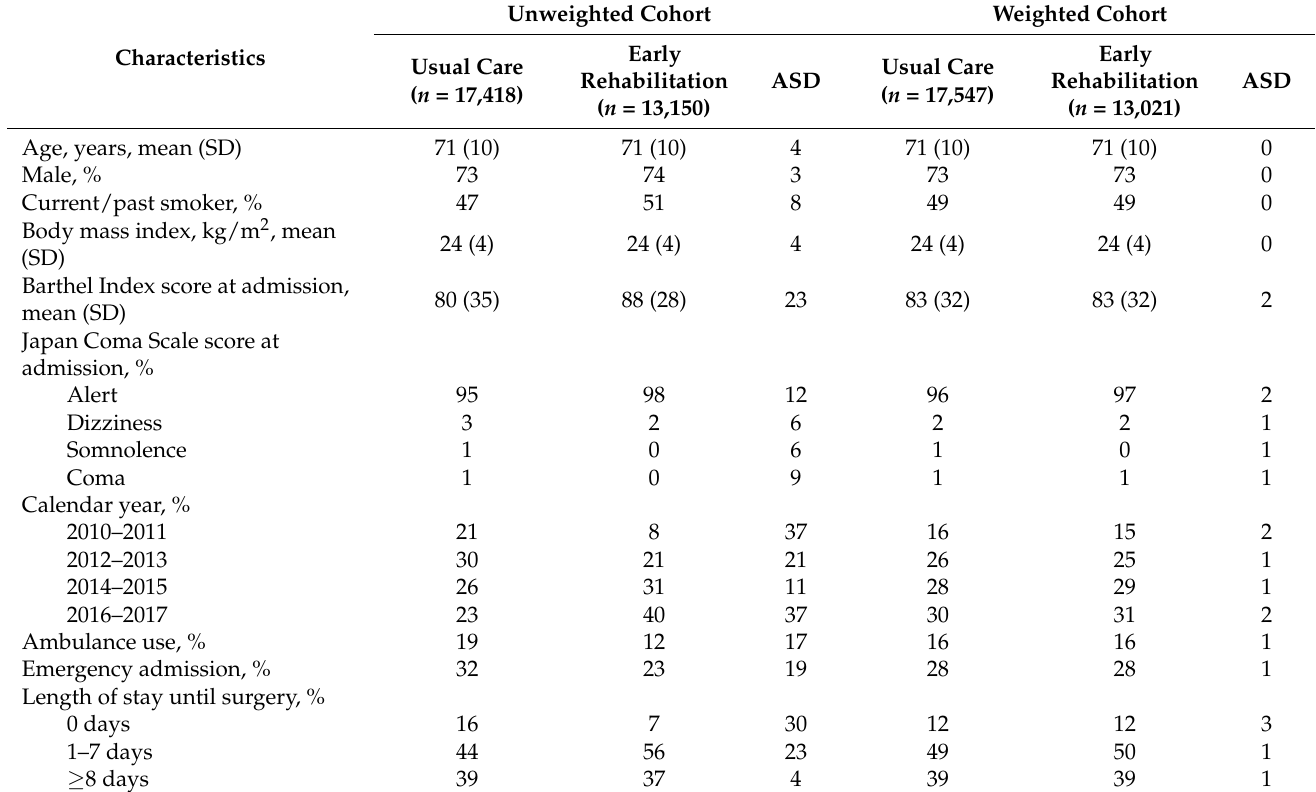
Table 1. Patients’ characteristics in the unweighted and weighted